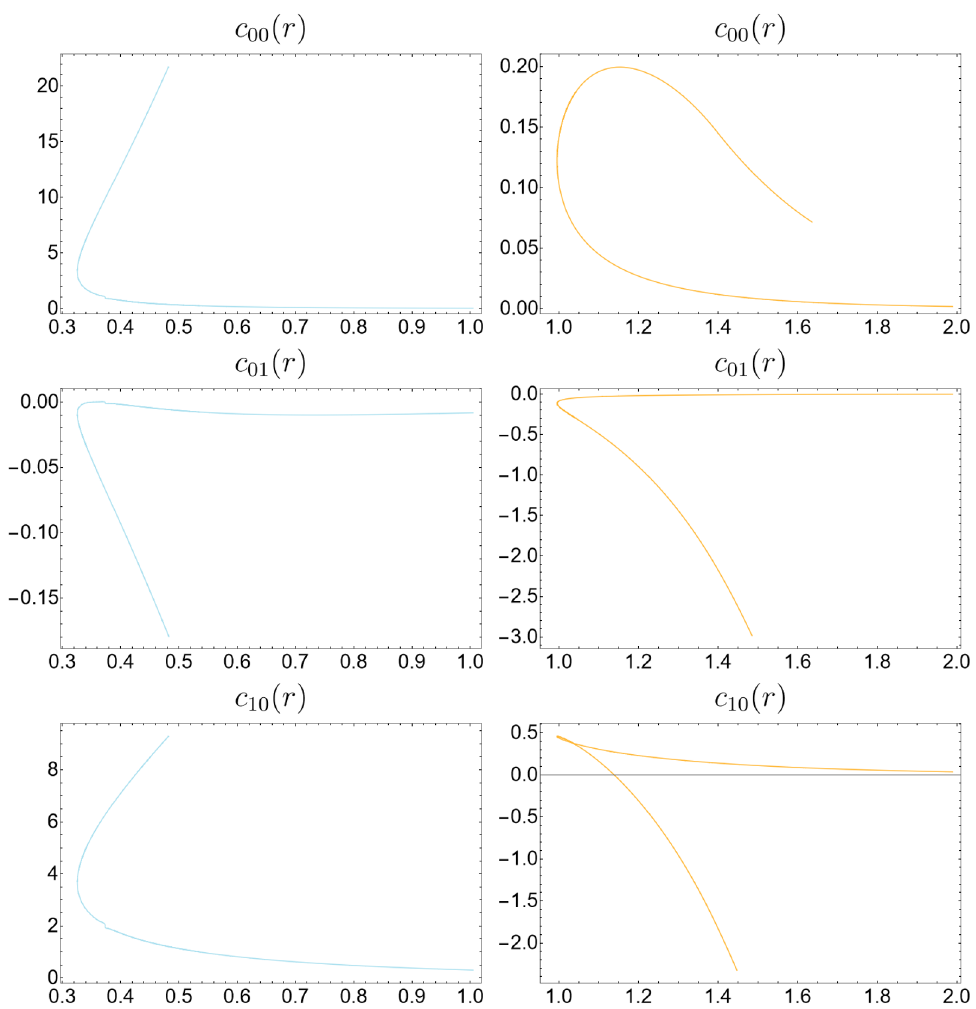
Figure 11. Non-vanishing coefficients in the algebraic relation (B.1) between the kernel ϕ a,l ( θ ) and the convolution C ( θ ) = (cid:15) ( θ ) − r cosh θ of the elliptic sinh-Gordon models with a = 1 / 2 and l = 1 / 2 . Panels on the l.h.s. correspond to the fermionic model, whereas panels on the r.h.s. correspond to bosonic